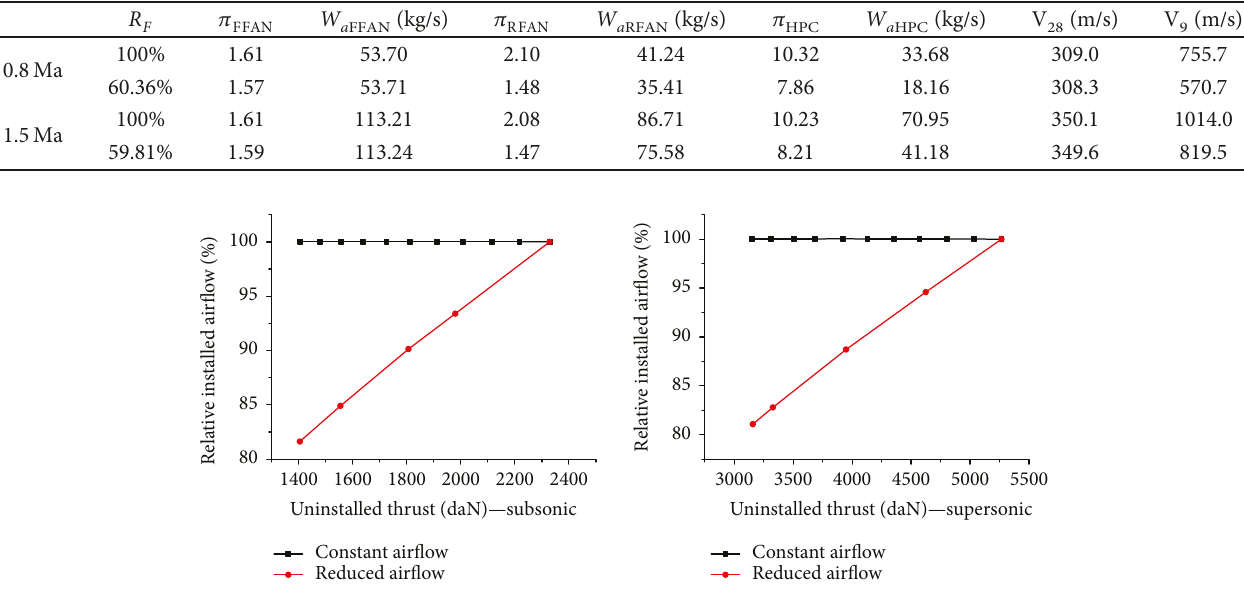
Figure 15: Variation of installed air fl ow during throttling.